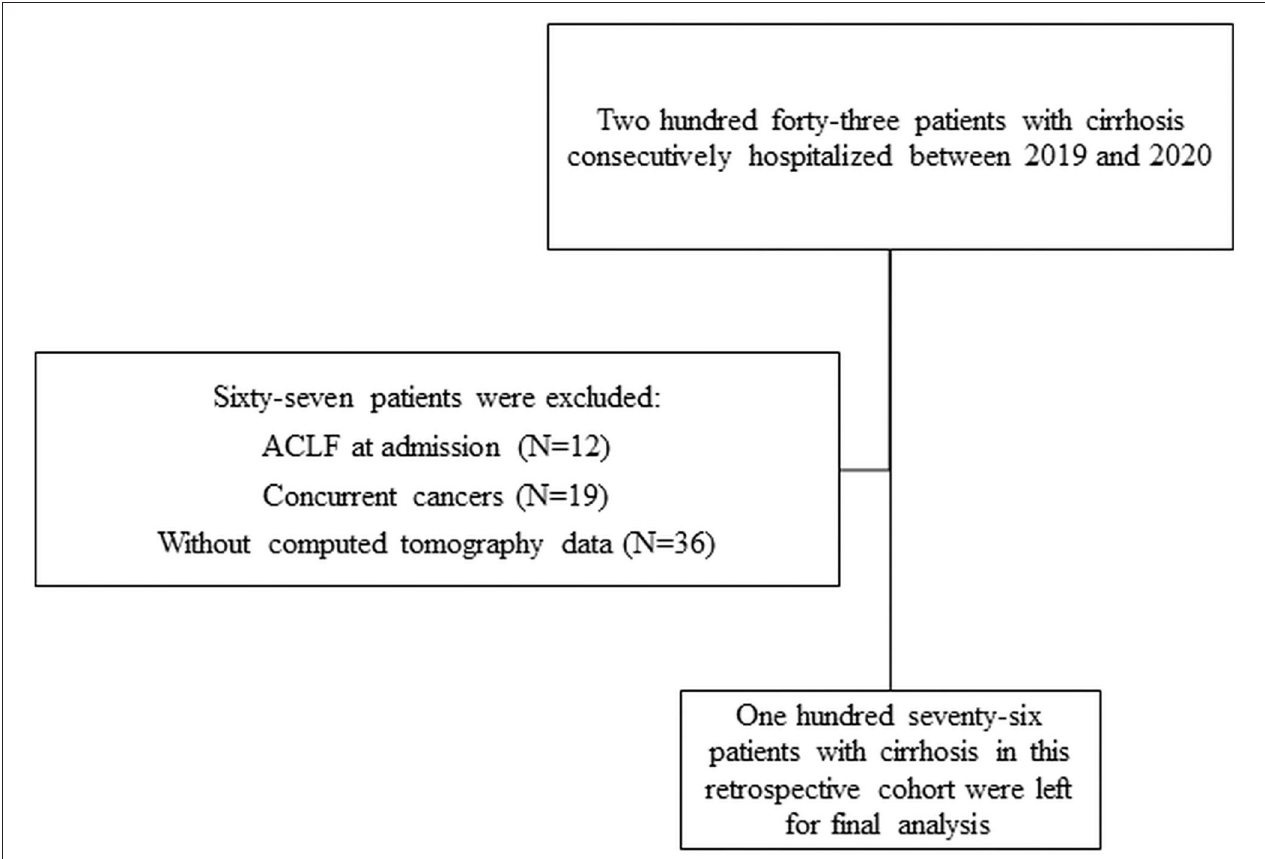
FIGURE 1 | A flowchart of study population, acute on chronic liver failure (ACLF).